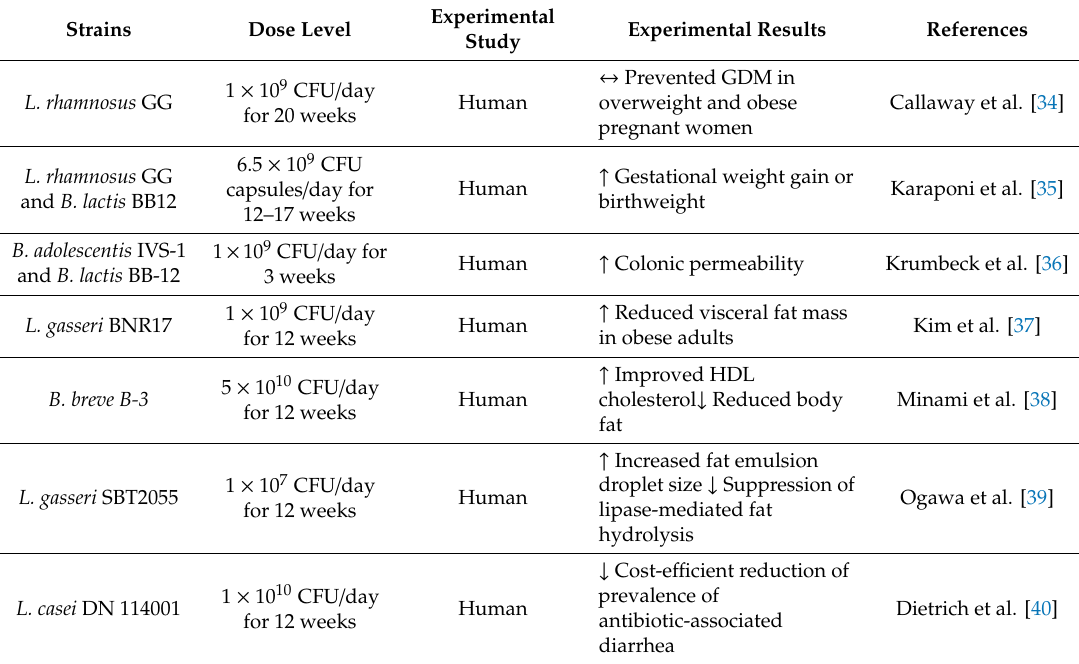
Table 2. Recent human trial for obesity study by probiotic strains. Reprinted with permission from Mishra et al. [28]. Copyright year